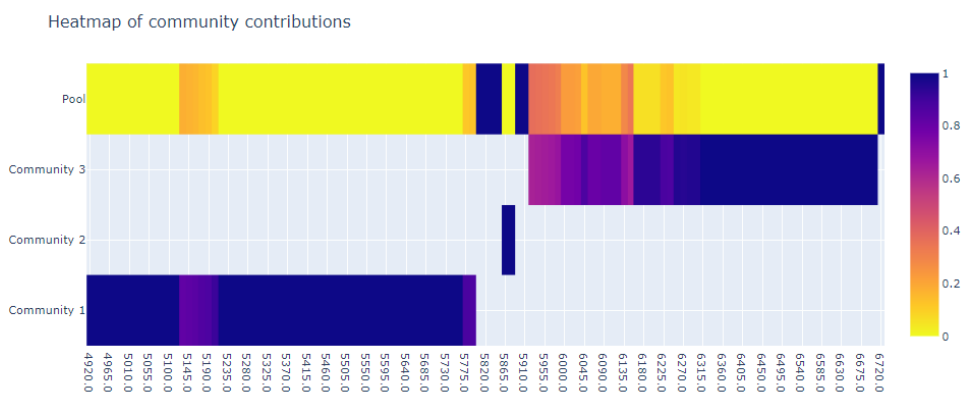
Figure 20. Complex communities for the second time window with regulations.